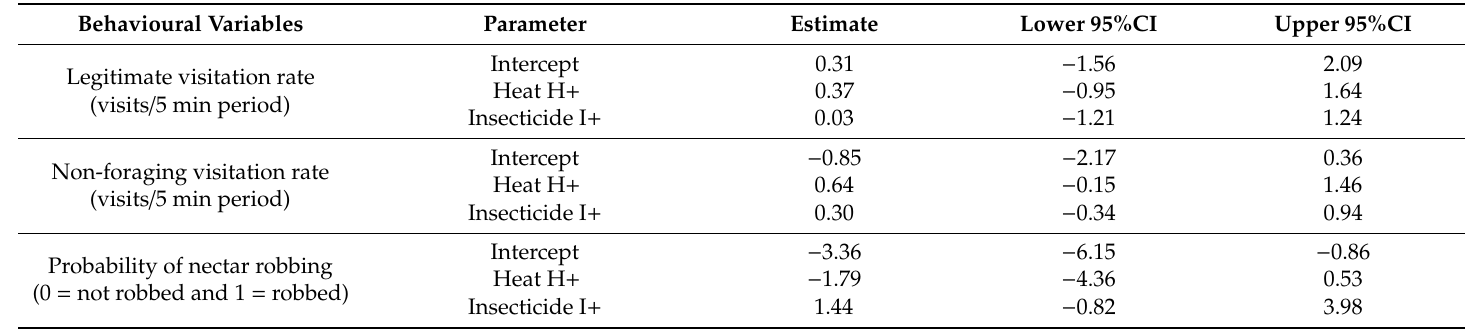
Table 4. Parameter estimates for the main e ff ects Heat (H- and H + ) and Insecticide (I- and I + ) on the behavioural variables analysed using Bayesian mixed models. The intercept represents the mean value at the H- (colonies maintained at 25 ◦ C) and I- (colonies reared on surcrose solution), and H + (colonies maintained at 31 ◦ C) and I + (colonies reared on sucrose containing 5 ng g -1 w / w of clothianidin) represent the di ff erence between the intercept and these factor levels. Cases where the 95% credible interval show no overlap with zero is evidence for an e ff ect of that parameter on pollinator